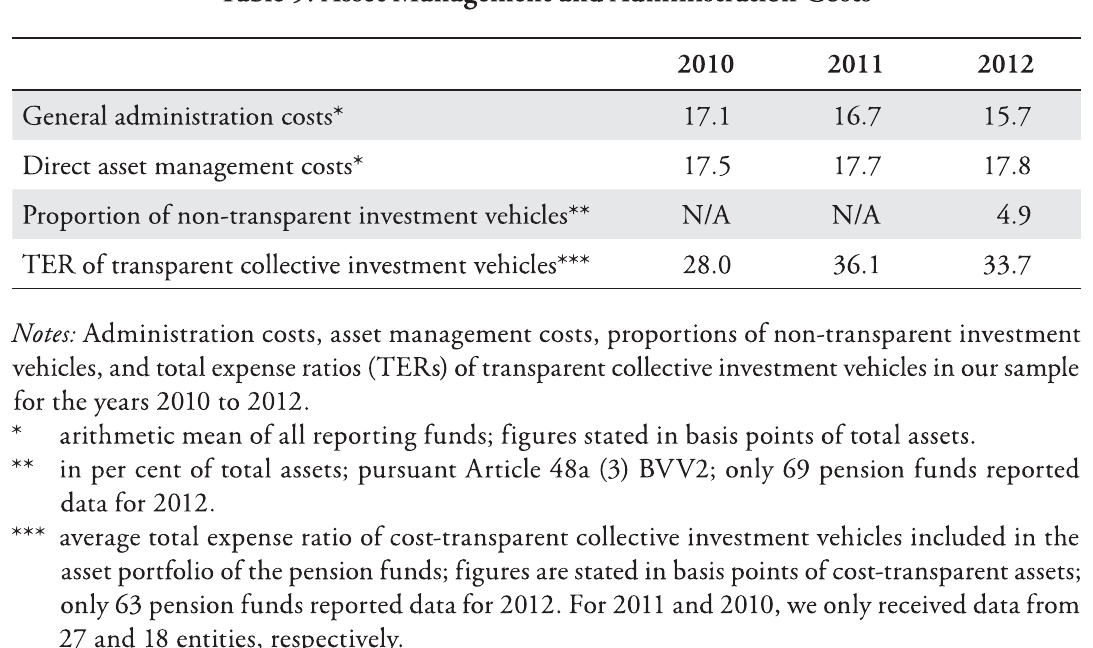
Table 9: Asset Management and Administration